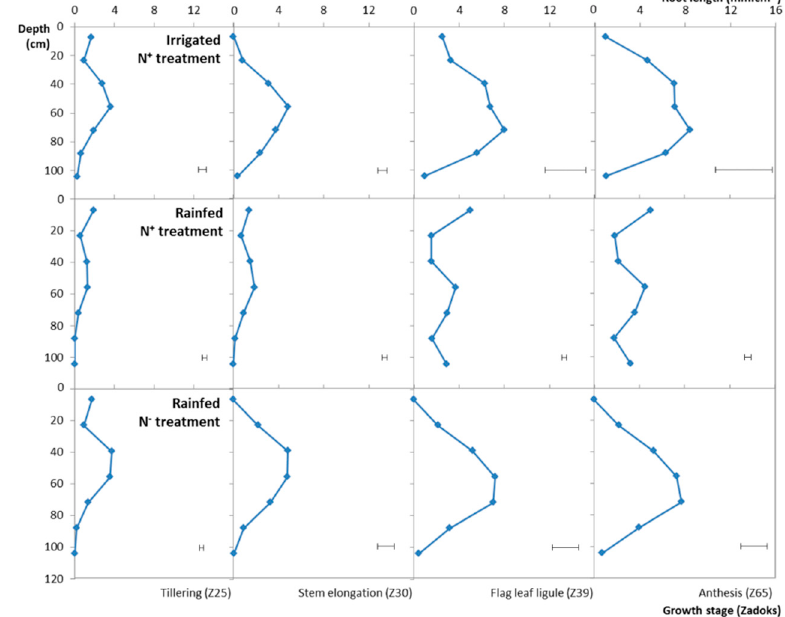
Figure 7. Treatments effects (Irrigation, Nitrogen) on the root length surface density profiles’ dynamic of the Miradoux durum wheat. The mean RLSD profiles (mm cm − 2 ) of Miradoux wheat cultivar are shown at tillering (Z25), stem elongations (Z30), flag leaf ligule (Z39) and anthesis (Z65) stages, with bars representing the median variation of RLSD. Globally, root profiles obtained under all conditions are shallow, their maximum of RLSD occurring above 80 cm depth followed by a rapid decrease. At harvest, the mean grain yield difference between I – N+ and I − N − is 0.92 t ha − 1 , smaller than the one obtained for the bread wheat Apache cultivar.